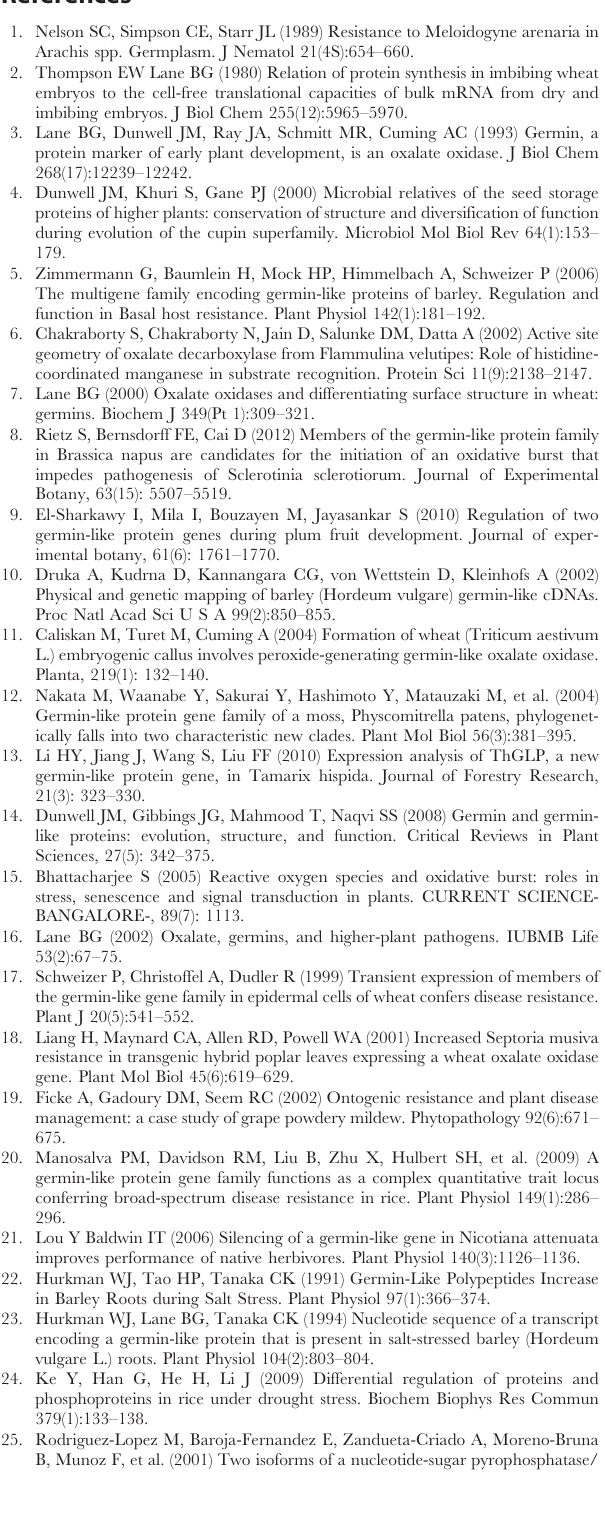
Table S1 Primers used to quantify transcripts from the peanut GLP family and 18S genes by qRT-PCR. Table S2 Primers used for AhGLP s transgenic and subcellular localization